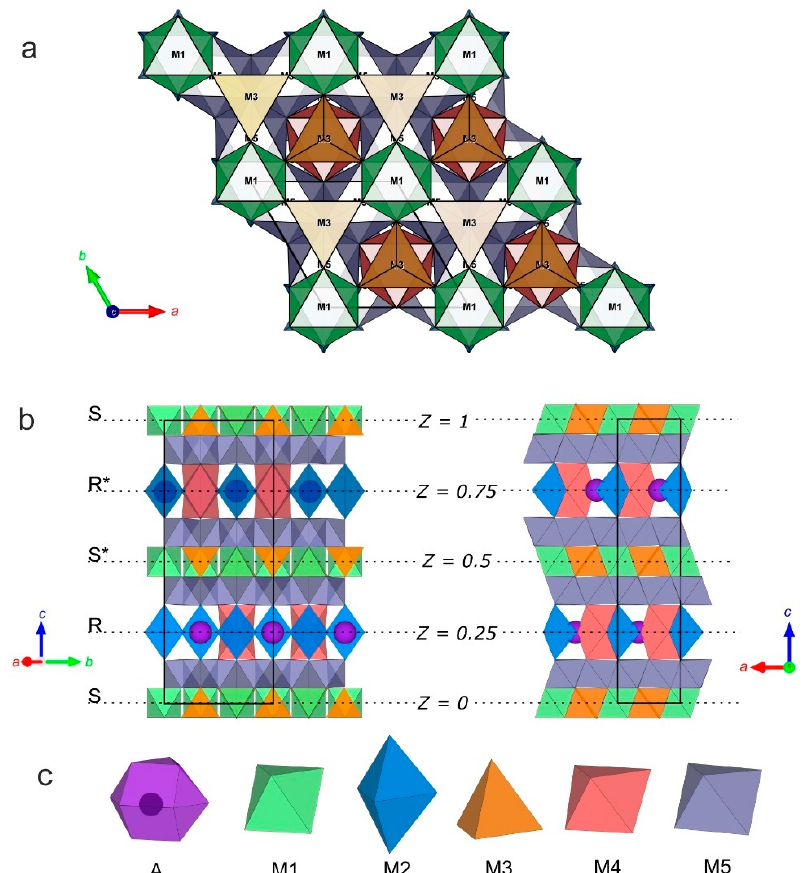
Figure 9. Crystal structure of synthetic yimengite: ( a ) view along the [0001] direction; ( b ) view along the [310] and [010] direction; and ( c ) types of structural polyhedra.